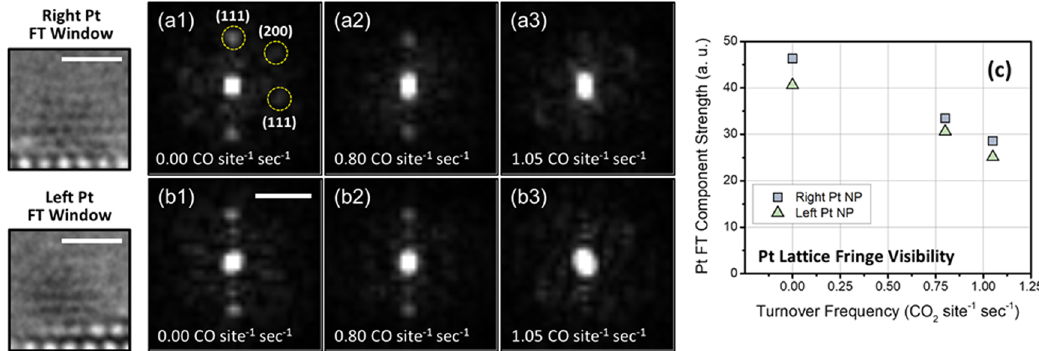
Fig. 5 Quanti fi cation of Pt nanoparticle (NP) fringe visibility and correlation with turnover frequency for CO oxidation. The fringe visibility is determined through Fourier transform (FT) analysis of windowed regions centered on the Pt NPs shown at far left. Scale bars in images correspond to 1 nm. a1 – a3 The modulus of the FTs after applying a Hanning fi lter to the windowed images of the right Pt NP at conditions corresponding to TOFs of 0.00, 0.80, and 1.05 CO site − 1 sec − 1 , respectively. b1 – b3 The modulus of the FTs taken from the left Pt NP are shown at the same respective conditions. The scale bar in ( b1 ) corresponds to 5.0 nm − 1 . c The Pt fringe visibility is quanti fi ed and plotted as a function of catalytic turnover frequency.